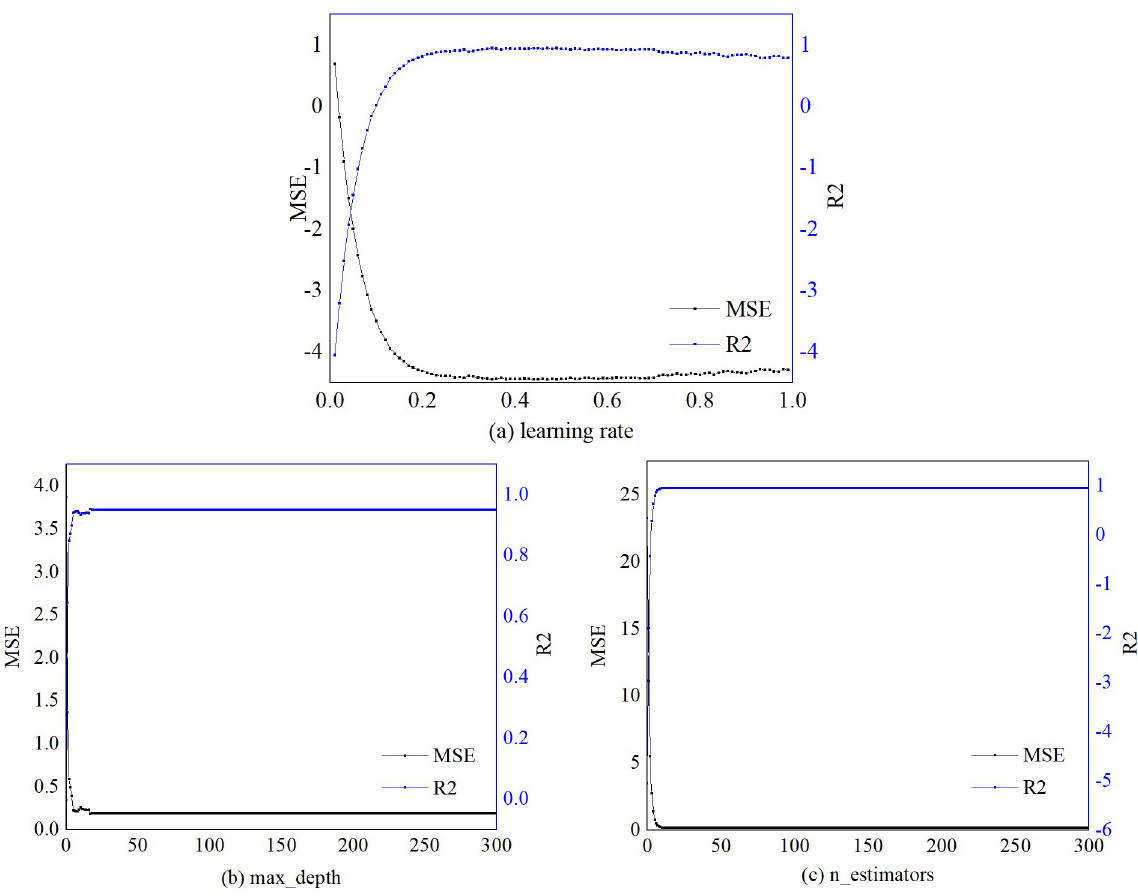
Fig 6. XGBOOST model parameters in the process of training the learning